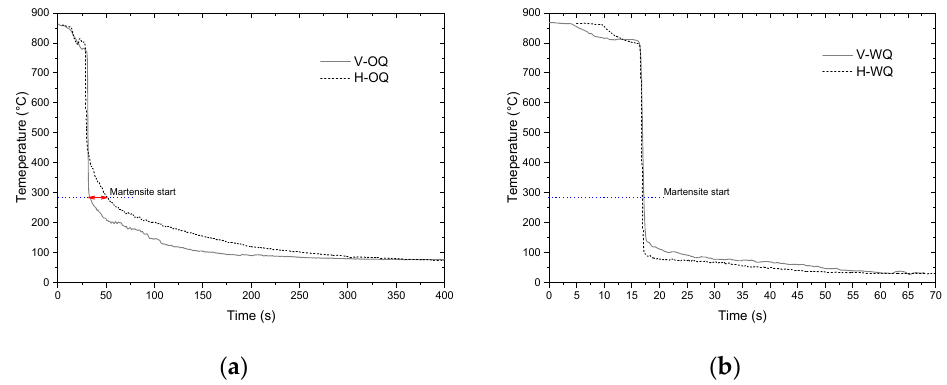
Figure 4. Thermal history of studied pieces in tow immersion modes: ( a ) oil quenching and ( b ) water quenching.